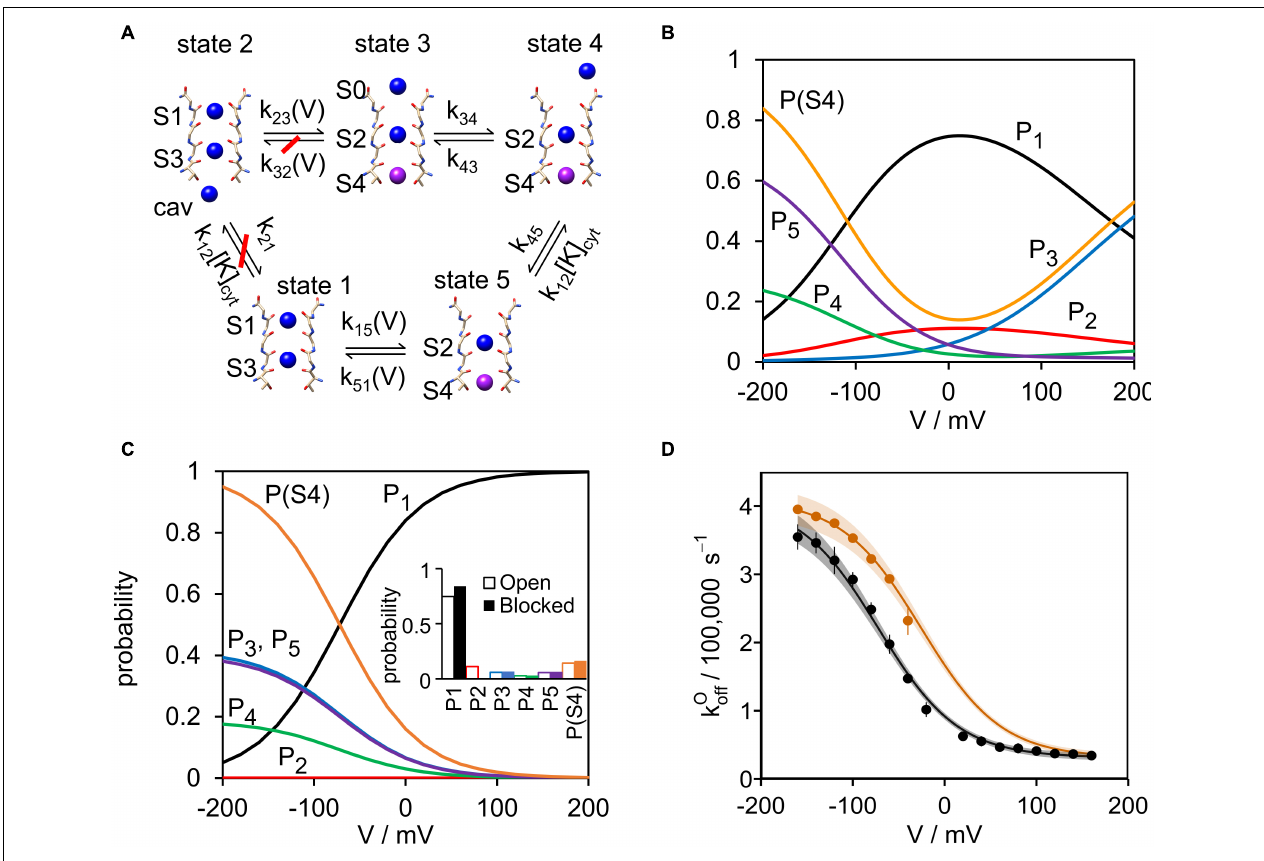
FIGURE 3 | Relating the voltage dependence of the rate constant of blocker release in the open state ( k O off ) to the ion distribution at S4 adjacent to the binding site of the blocker. (A) 5-state model of ion hopping (Roux, 2005) with the rate constants k ij ( i , j = 1 to 5) obtained from the previous analysis (Rauh et al., 2018). Numerical values for the rate constants are given in Supplementary Table S1 (B,C) . The probabilities P m ( m = 1 to 5) of the occurrence of the states 1 to 5 in the model of Roux (2005) calculated from Eqs. S4 to S9 for the case (B) that the channel is open and not blocked (redrawn from the original data of Rauh et al., 2018) and (C) that the channel is blocked ( k 12 = k 21 = k 32 = 0). P (S4) is the probability that there is an ion in binding site S4 (purple in panel A ) close to the binding site of the blocker. According to panel (A) , P (S4) = P 3 + P 4 + P 5 . The inset shows the probabilities for the open and blocked channel at 0 mV, as taken from panels (B,C) . (D) Comparison of the measured k O off with the values predicted by Eq. 4 based on P (S4). Black line: Fit of the experimentally determined k O off (black circles, pooled from all TPrA concentrations) with 100 mM symmetric KCl. Parameters a and b were free fit parameter in Eq. 3. Orange line: Prediction of Eq. 3 for 100 mM cytosolic and 500 mM external KCl. Parameters a and b were taken from the symmetric fit. Orange circles: experimentally determined k O off (with 5 mM TPrA). Data points show mean and standard deviation, shaded areas depict 99% confidence